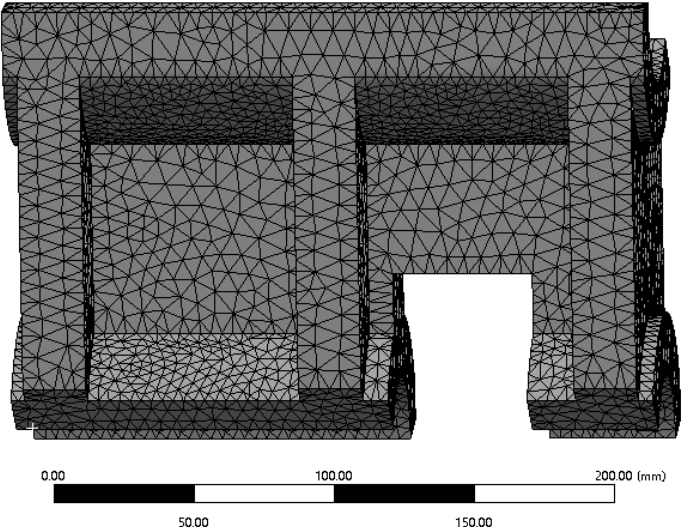
20 of 26 Figure 27. Optimization result drive rod. Table 4. Parameter values of lightweight drive rod before and after optimization. a(mm)